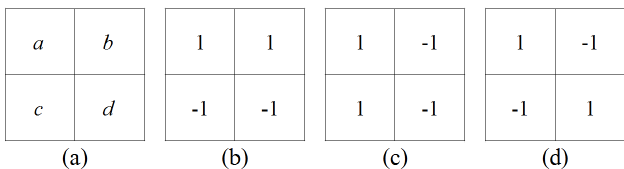
Figure 7. Haar filters for different directions. ( a ) An example of an original 2 × 2 pixel block, on which each Haar filter is performed. ( b ) The horizontal Haar filter, ( c ) the vertical Haar filter and ( d ) the diagonal Haar filter; ( b – d ) will be applied on a , b , c and d to generate the corresponding Haar responses of different